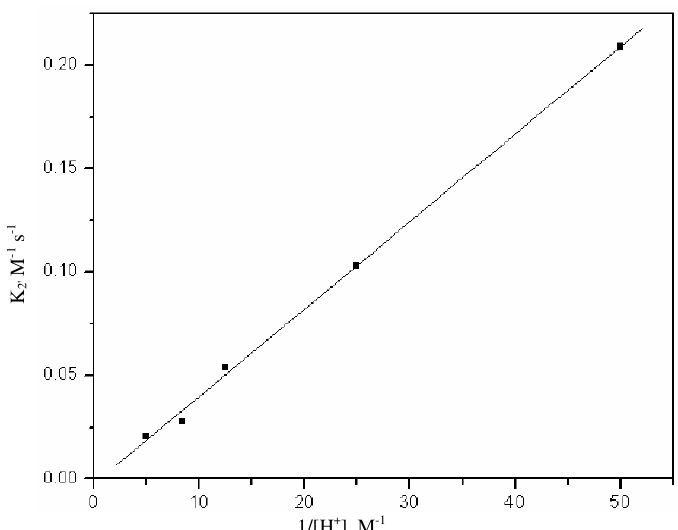
Figure 2 . Plot of k vs . 1/[H + ] for the oxidation of glutamic acid with NBP 2 Table 2. Influence of ionic strength and phthalimide (NHP) on reaction rate for the oxidation of glutamic acid with NBP at 303 K a [I], M